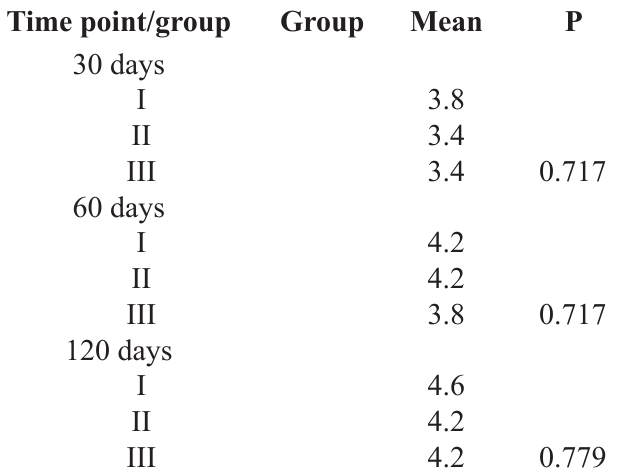
FIGURE 2 - Light microscopy findings at 60 days postoperatively, approximately 100x magnification, hematoxylin and eosin